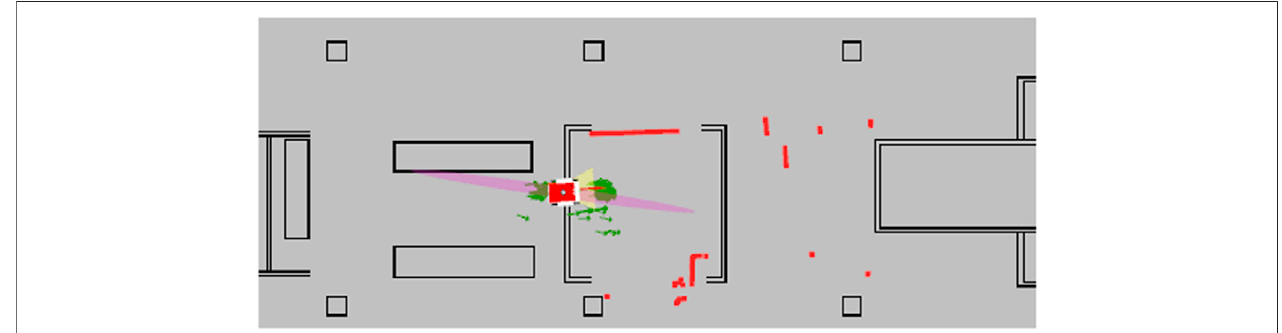
FIGURE 11 | The AMCL method failing to converge, and providing a number of wrong hypotheses while including a maximum likelihood estimate that is incorrect andintersectswithoccupiedgeometry.Theredsquareinthecenteristherobotpositionestimateandthegreenarrowsareparticles.TheLiDARpointsareshowninred as well.